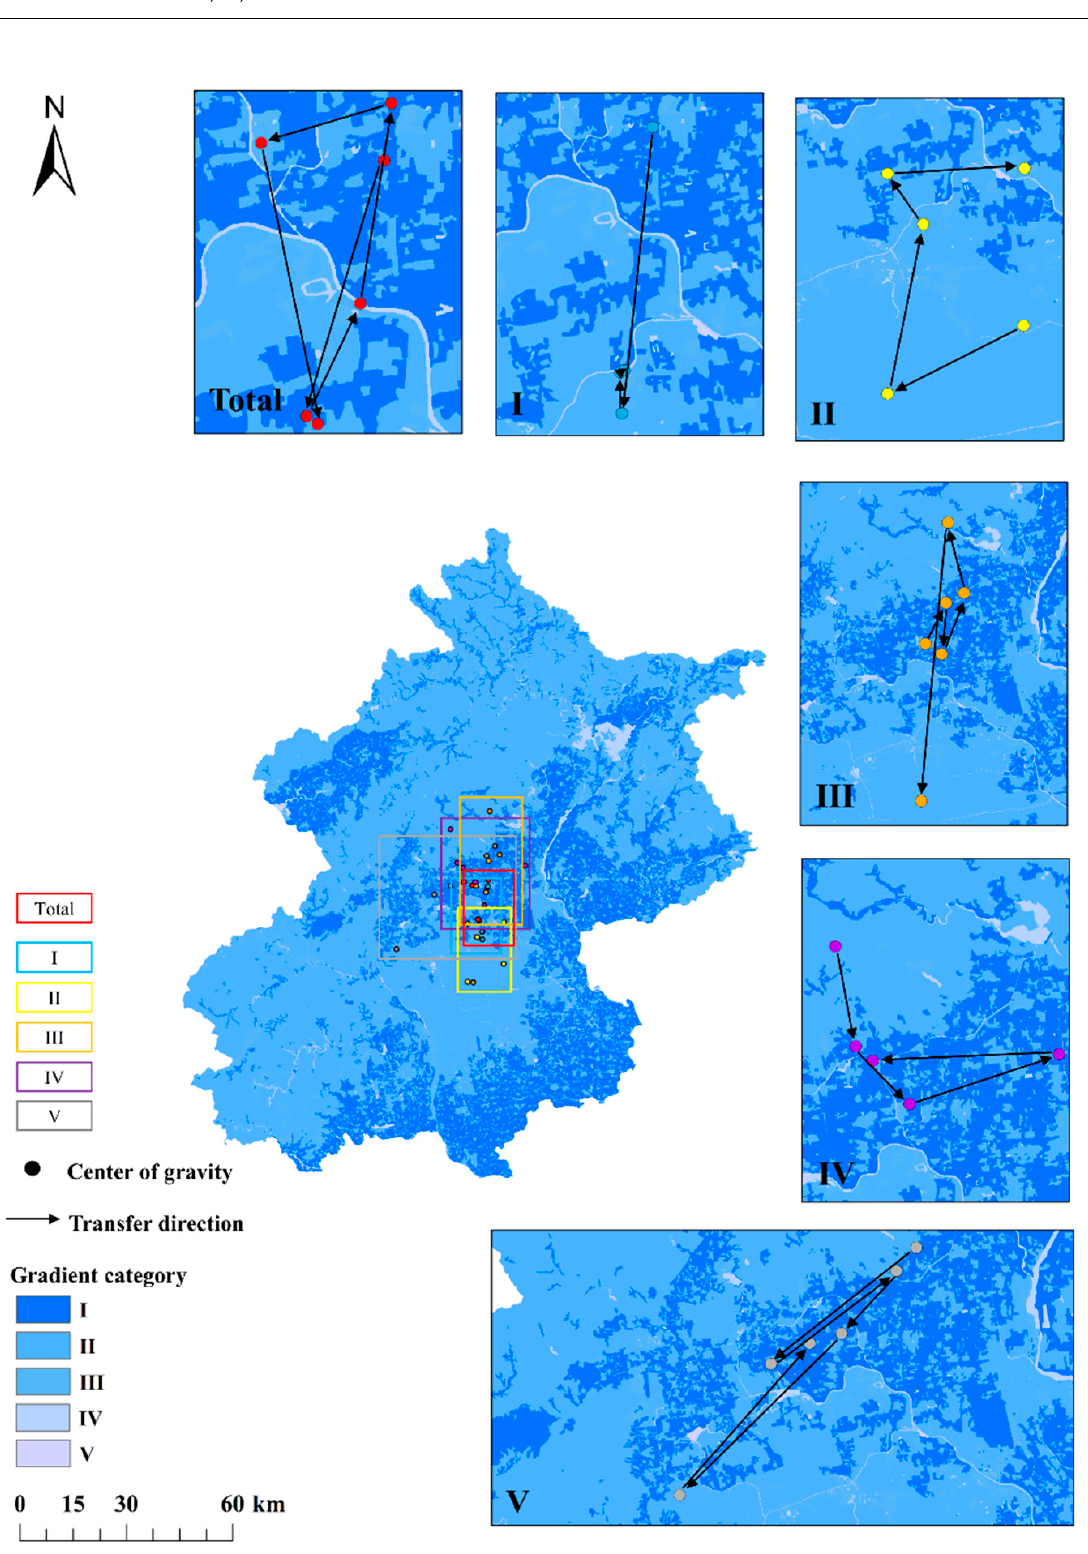
Figure 7. Land use maps in Beijing from 2018 to the two planned scenarios (in 2035 and 2060).